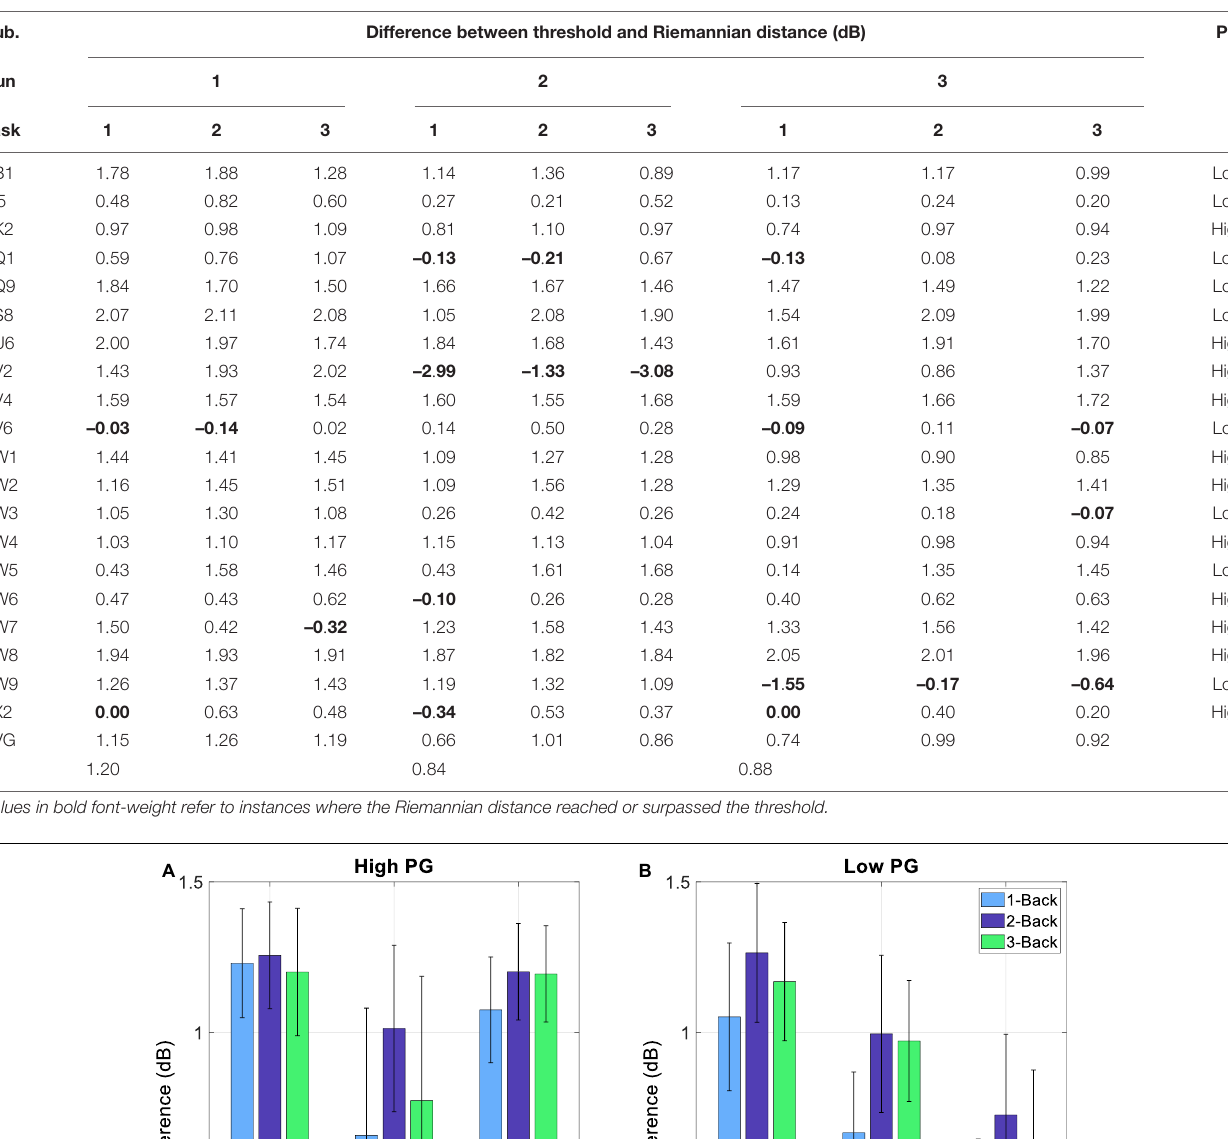
high performers showed only small BP increases and even BP decreases between runs. Furthermore, the post hoc tests showed only a statistically significant difference at the low PG between run 1 and run 3. These findings led to the expected assumption